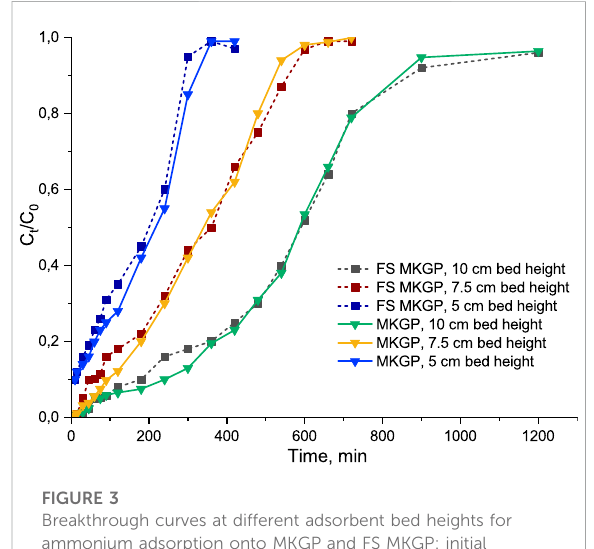
FIGURE 3 Breakthrough curves at different adsorbent bed heights for ammonium adsorption onto MKGP and FS MKGP: initial ammonium concentration 40 mg/L, EBCT 4 min.